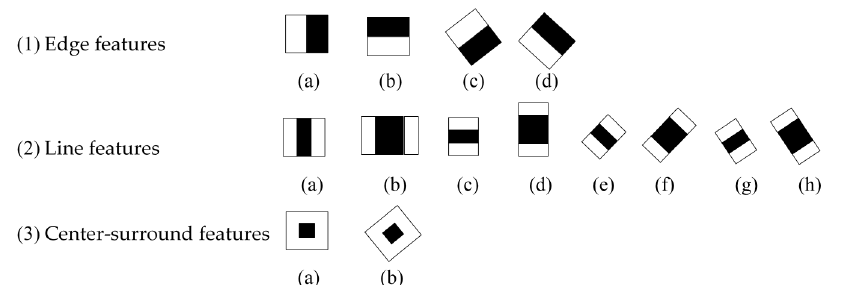
Figure 3. Feature prototypes of edge features, line features and center-surround features. The black and white areas respectively stand for negative and positive weights.